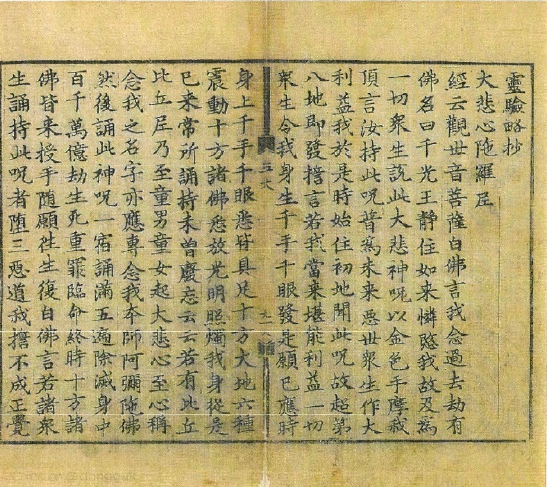
Figure 2. Brief Transcriptions of Efficacious Resonance (Yŏnghŏm yakch’o) in literary Sinitic ( Odae chin ŏ n 1485B, p. 41).